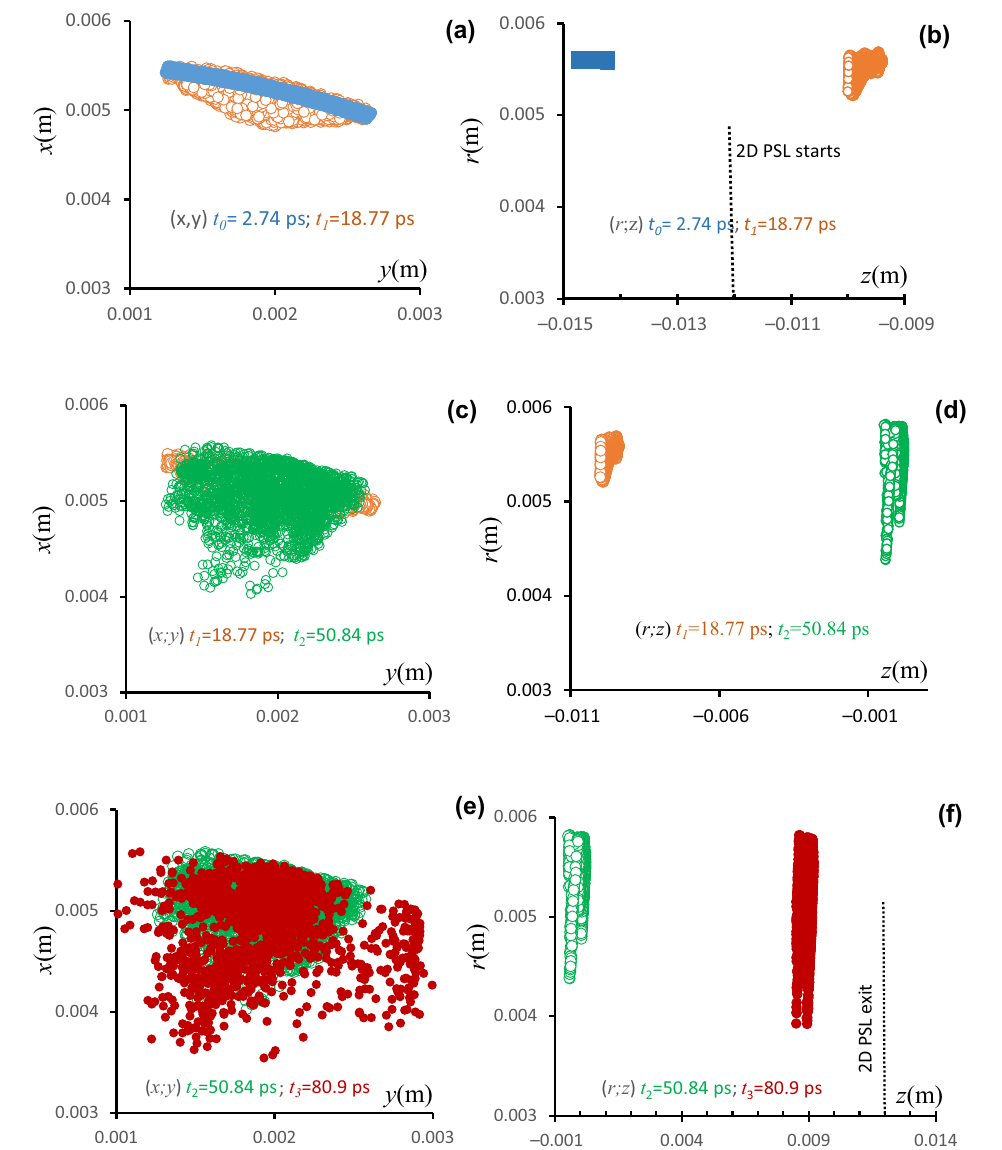
FIG. 2. Results of numerical studies using 3D PiC code MAGIC . Distributions of the electrons inside the driver bunch in ð x; y Þ (first column) and ð r; z Þ cross sections measured at different moments of times (a) and (b) 2.74 (solid blue dots) and 18.77 ps (hollow orange dots); (c) and (d) 18.77 (hollow orange dots) and 50.84 ps (hollow green dots); (e) and (f) 50.84 (hollow green dots) and 80.9 ps (solid red dots). The 2.74 and 80.9 ps are corresponding to injection in and exit from the AMWA structure, while dashed lines in Figs. 2(b) and 2(f) show the entrance and exit of the